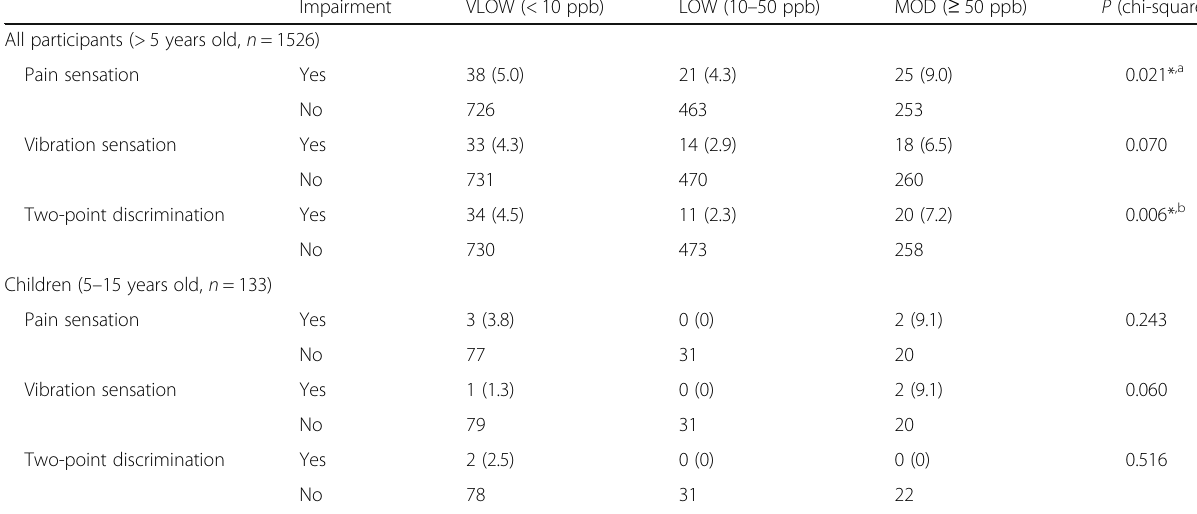
Numbers indicate the number of participants Numbers in parentheses indicate the percentage of “ yes ” participants in each ACDW group Statistical analyses were performed using the chi-square test. * P <0.05; statistically significant difference Yes = present; no = absent